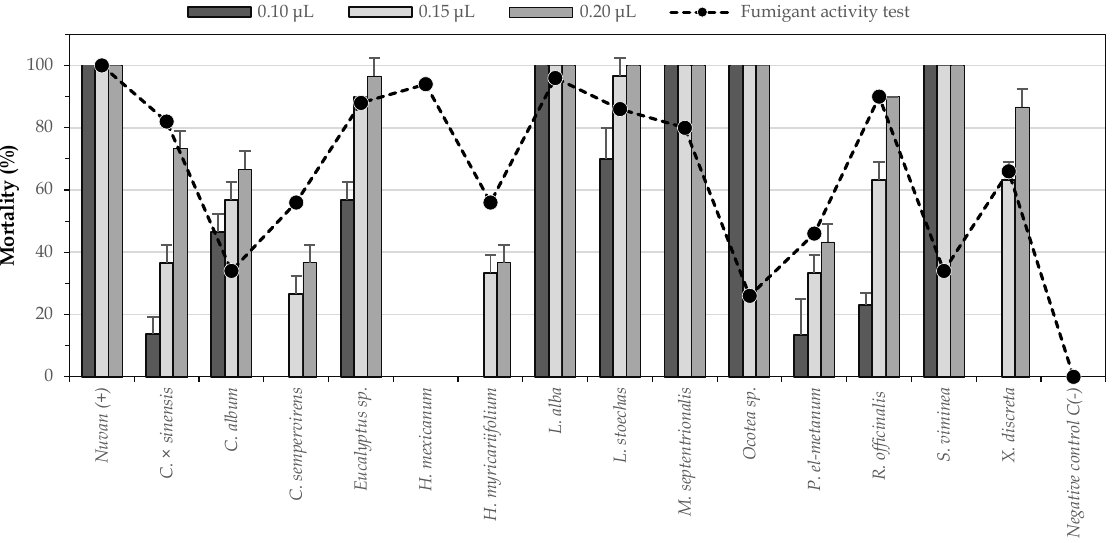
Figure 6. Contact toxicity results of the 14 EOs that produced fumigant mortalities greater than 25%. In Figure 6, the contact toxicity results for the 10 AEs that did not cause high fumigant effects are presented. It is observed that the AEs corresponding to S. viminea , M. septen- trionalis , Ocotea sp. and L. alba were the most active in the topical contact test, causing mortality rates higher than 90% in all the quantities evaluated. These results indicate that EOs consisting mainly of phenylpropanoids and sesquiterpenes exerted an action mainly by contact against S. zeamais . It has been described in structure-activity relationship studies that less volatile compounds tend to present a higher toxicity by contact [39].